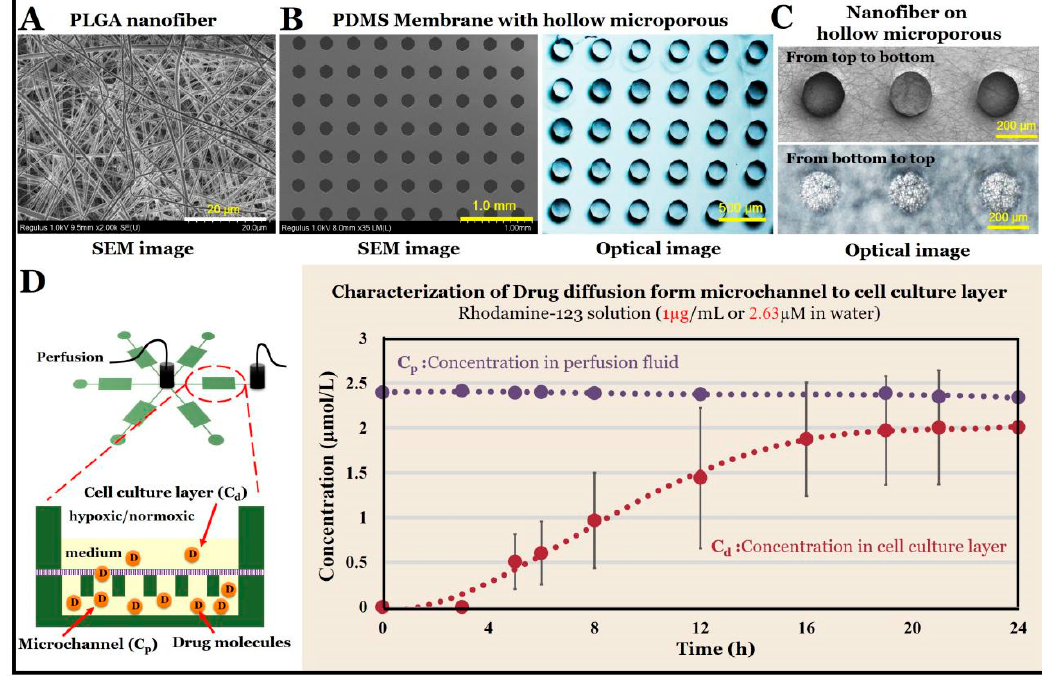
Figure 3. ( A ) Scanning electron microscope (SEM) image of PLGA nanofibers. ( B ) SEM and optical images of the polydimethylsiloxane (PDMS) hollow microporous membrane. ( C ) Optical images of the composite membrane in different directions. ( D ) Characterization of drug diffusion from the microchannel to the cell culture layer. A 2.63 μ M Rhodamine-123 solution in water was perfused into the microchannel at 1 mL/h. The cell culture layer was initially filled with 500 μ L of pure water; after perfusion, the absorbance was detected every several hours. ( n = 5) The drug concentration in the cell culture room and in the perfusion fluid were determined by standard UV-visible spectrophotometry.